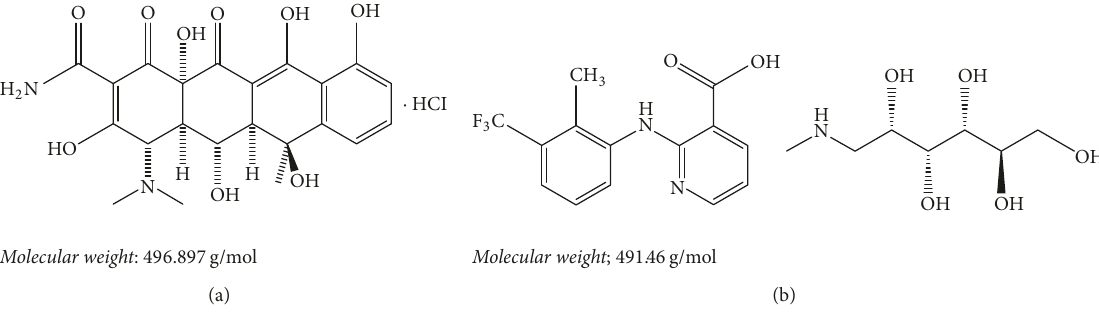
Figure 1: Chemical structures of (a) Oxytetracycline HCl and (b) Flunixin